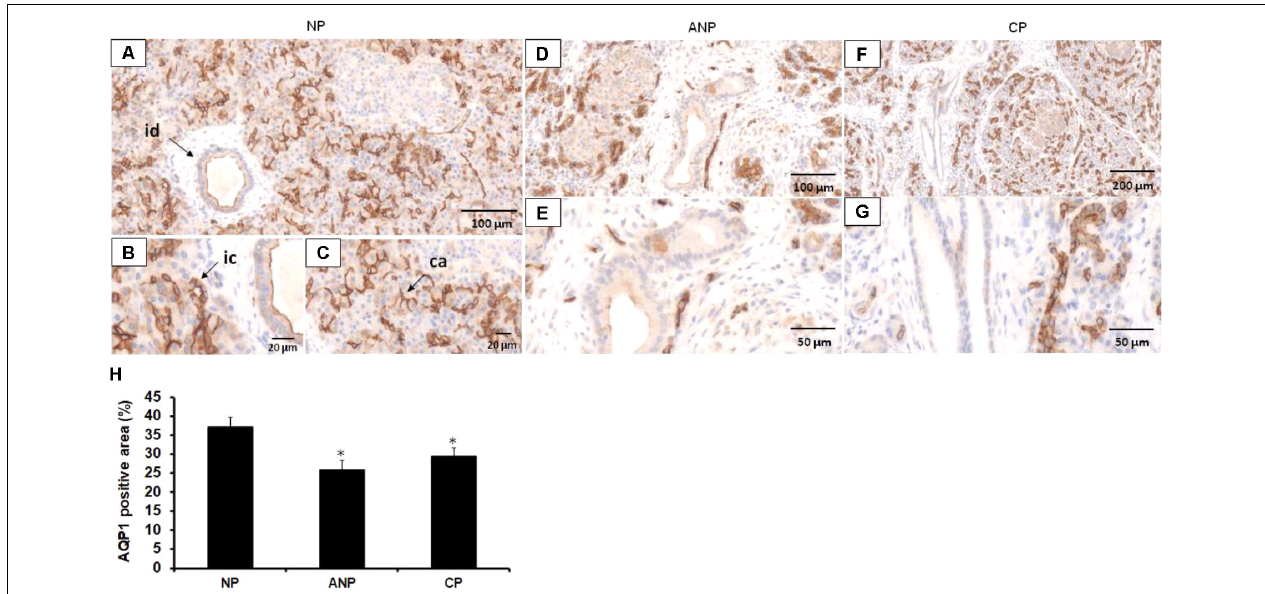
FIGURE 6 | Expression of AQP1 in patients with acute and chronic pancreatitis. Representative histological images show expression and localization of AQP1 in normal human pancreas (NP, A–C ) acute necrotizing pancreatitis (ANP, D,E ) and chronic pancreatitis (CP, F,G ) samples. AQP1 immunoreactivity was detected in inter/intralobular and intercalated ducts, in the acinar and centroacinar cells of the normal pancreas. In contrast, expression of AQP1 strongly decreased in ANP and CP. id, interlobular duct; ic, intercalated duct; ca, centroacinar cells. (H) Intensity of diaminobenzidine staining was measured in pancreas samples by ImageJ software and expressed as percentage of total pancreatic area. ∗ p ≤ 0.05 vs. normal pancreas, n =